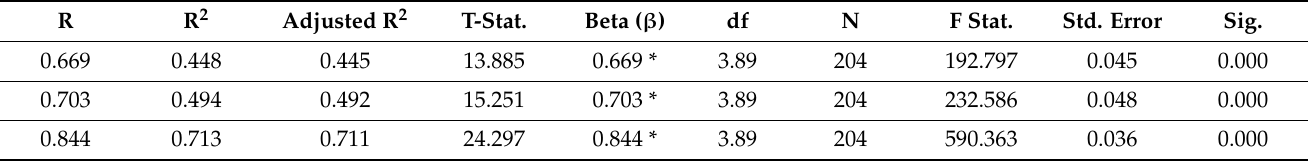
Table 2. Hypotheses